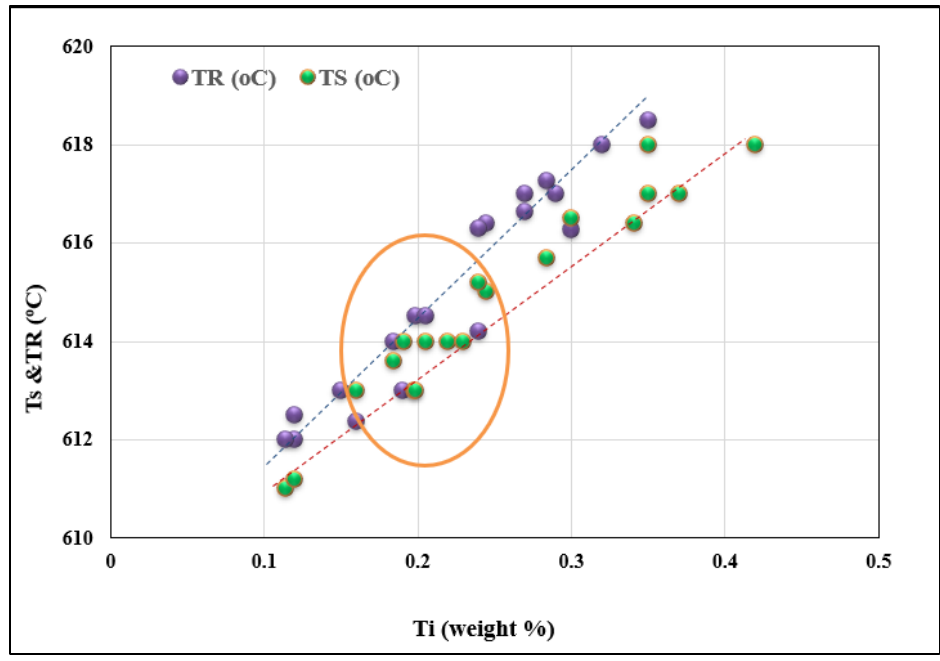
Figure 8. Effect of superheating at 950 °C on the T S and T R temperatures. The pouring temperature was 750 °C.